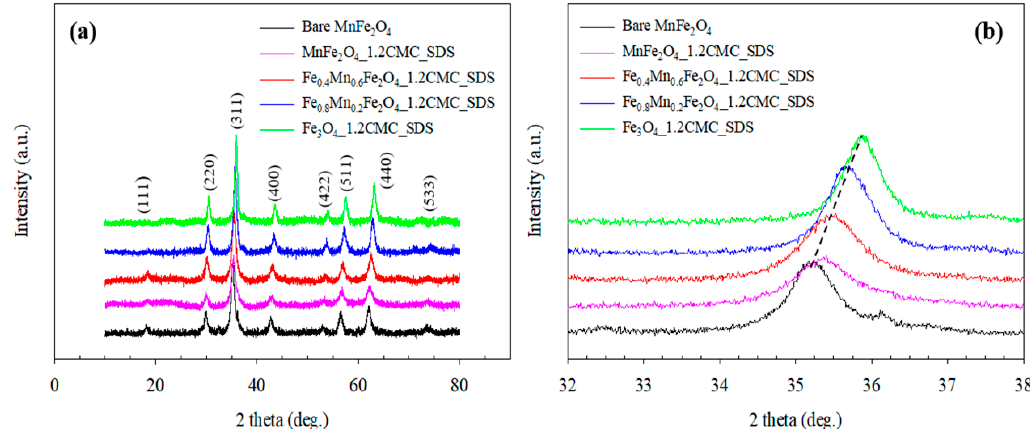
Figure 3. XRD patterns of: ( a ) the synthesized bare MnFe 2 O 4 and Fe (1-x) Mn x Fe 2 O 4 _1.2CMC_SDS ferrite nanoparticles; and ( b ) the peak position of (311) diffracted as a function of molar ratios of Mn 2+ :Fe 2+ . All of the magnetic ferrite XRD patterns show the main diffraction peak at around 2 θ ≈ 35.1°–35.9° corresponding to the (311) crystal plane, and the averaged crystalline size (D) was calculated from this peak by using the Debye-Scherrer’s Equation (3) [45]: